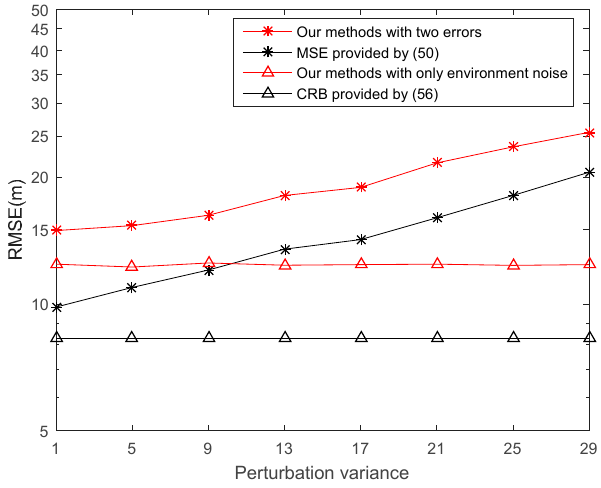
Figure 6. RMSEs versus perturbation variance of system errors.